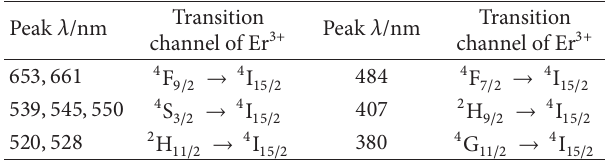
Table 1: Relationship between PL peak and Er 3+ transition channel. Transition Peak 𝜆 /nm